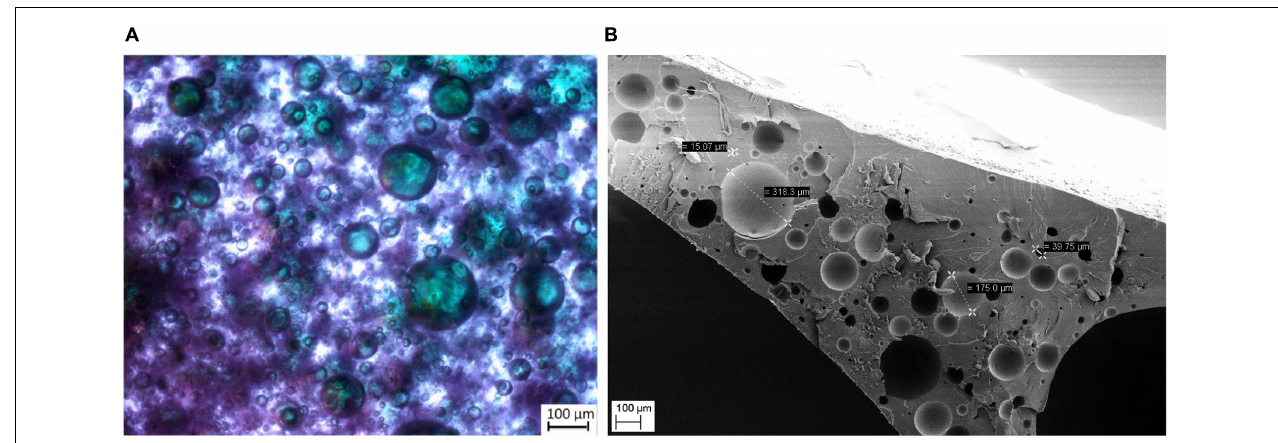
FIGURE 2 | Exemplary microscopic images of aqueous inclusions in a polyurethane matrix. (A) Light microscope image: spherical inclusions (highlighted blue/green by an aqueous solution of bromophenol blue) in the polyurethane matrix. (B) SEM image of a polyurethane cross section.